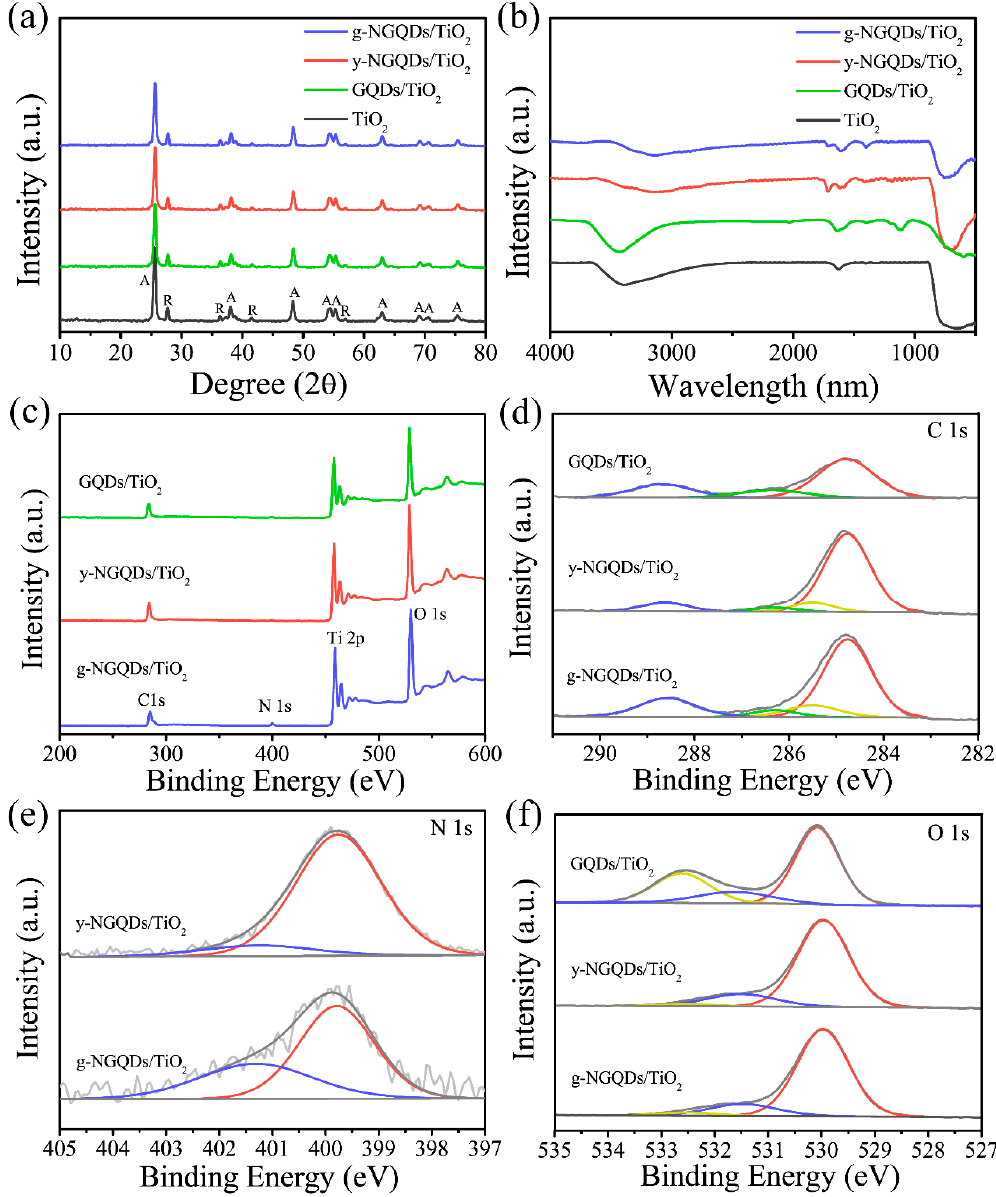
Figure 2. ( a ) XRD patterns (A represents the anatase phase, R represents the rutile phase) and ( b ) FT-IR (Fourier transform infrared)spectra of TiO 2 , GQDs/TiO 2 , g-NGQDs/TiO 2 and y-NGQDs/TiO 2 composites; ( c ) XPS (X-ray photoelectron spectroscopy) survey spectra, ( d ) C 1s, ( e ) N 1s and ( f ) O 1s high-resolution spectra of GQDs/TiO 2 , g-NGQDs/TiO 2 and y-NGQDs/TiO 2